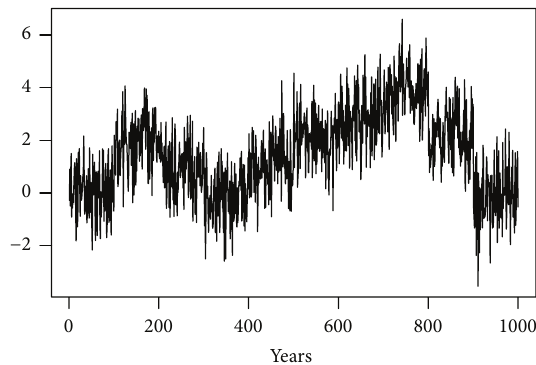
Figure 4: Artificially generated time series with abrupt changes every 100 time